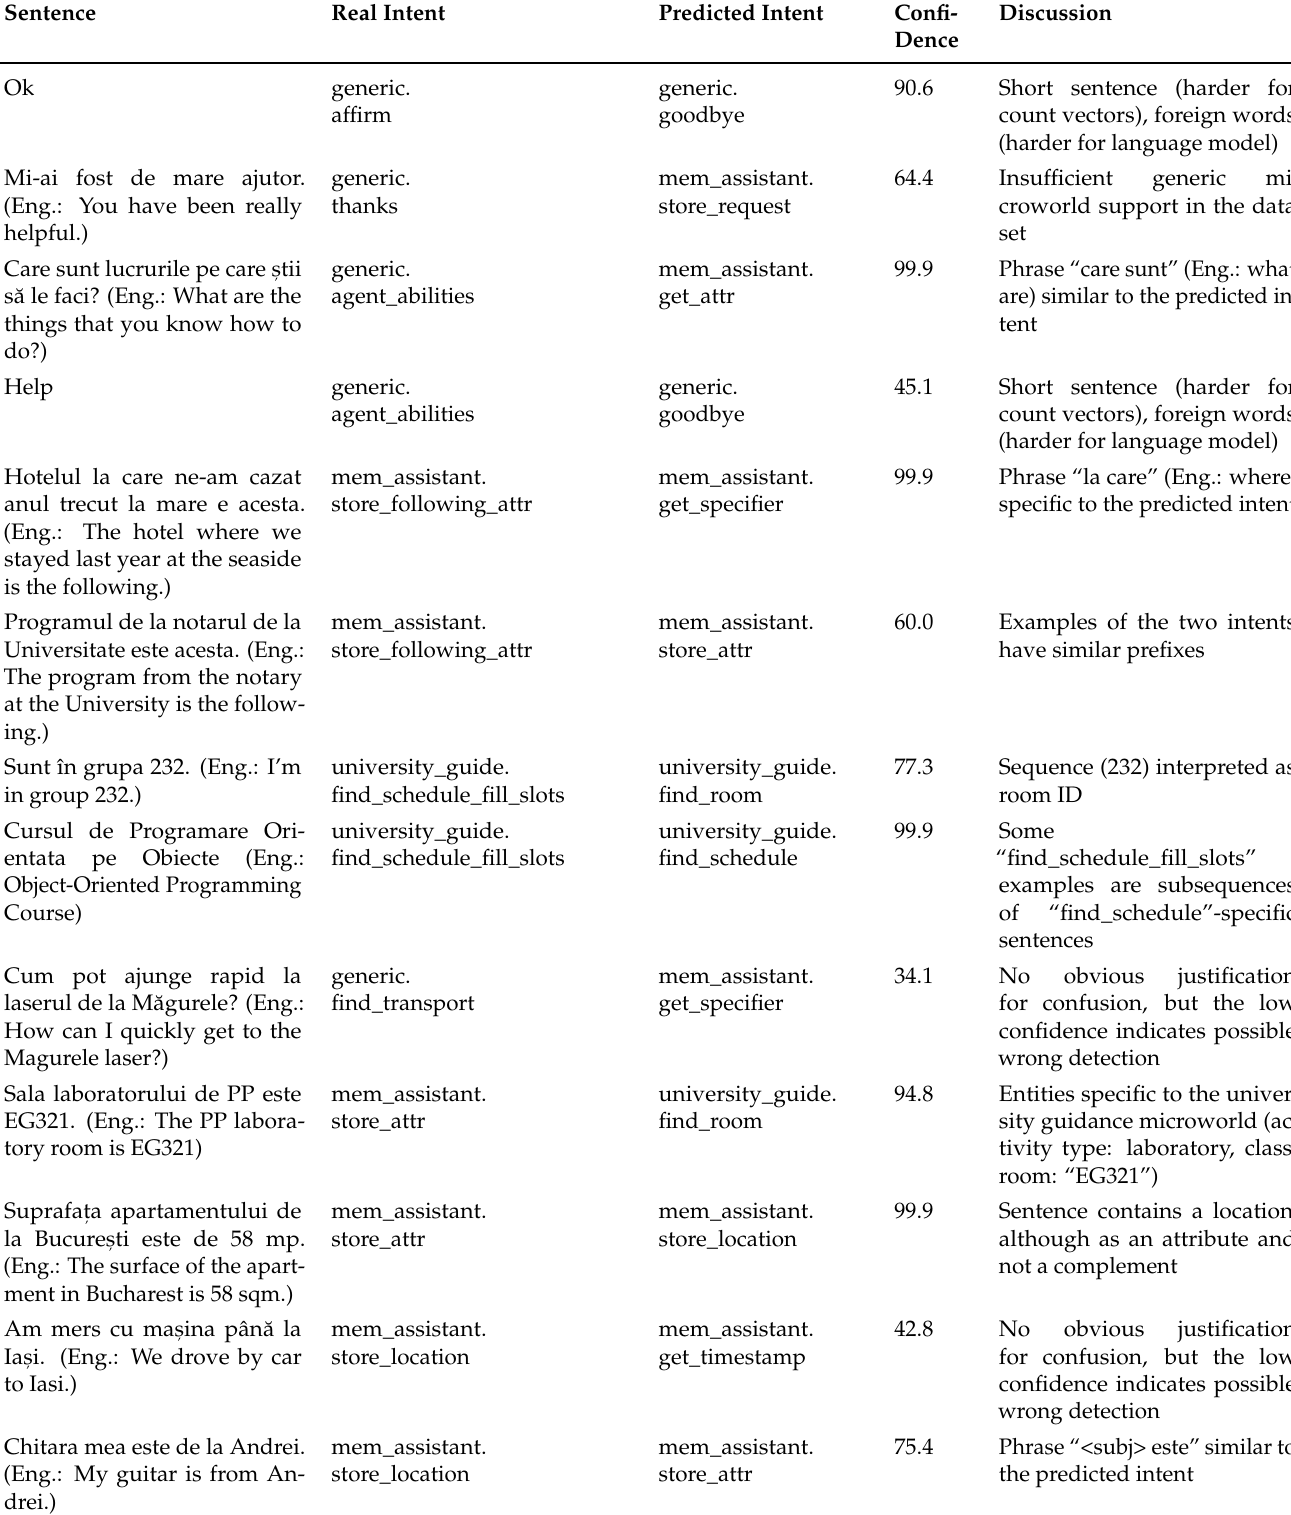
Table 3. Error analysis for intent